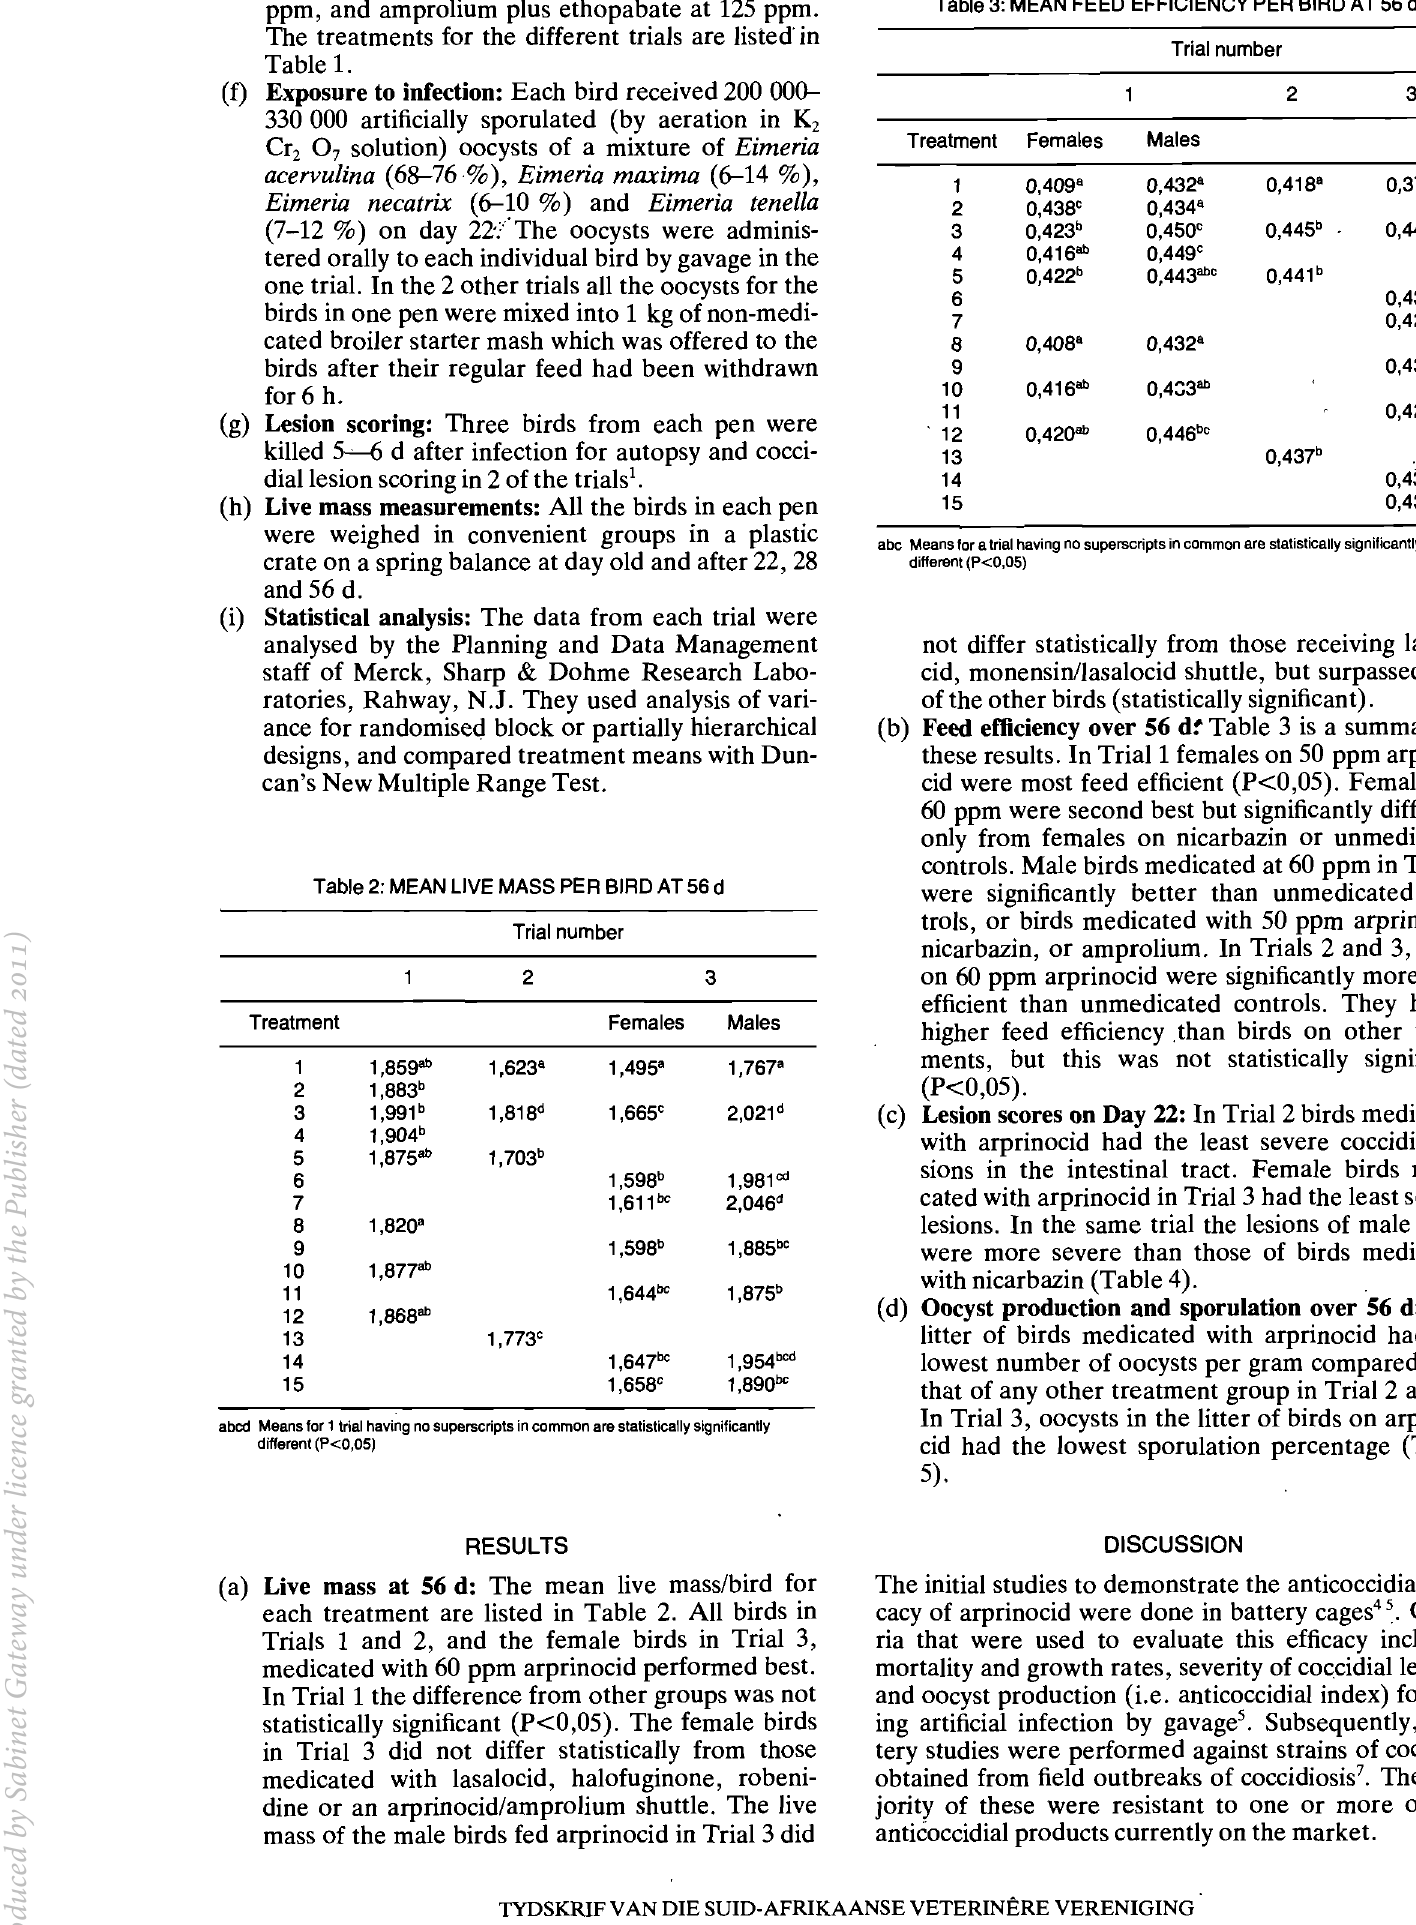
Table 3: MEAN FEED EFFICIENCY PER BIRD AT 56 d